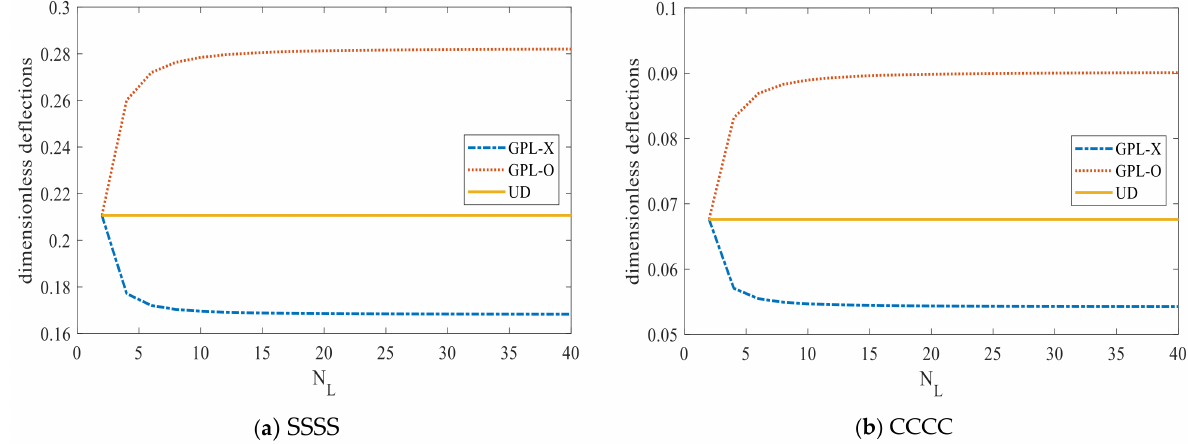
Figure 12. Dimensionless deflection vs. number of layers, for different distribution patterns of reinforcement ( b/a = 1, a / h = 25, ∆ = 0.3%, p = 10 5 ) : ( a ) SSSS boundary conditions, ( b ) CCCC boundary conditions. 0 GPL